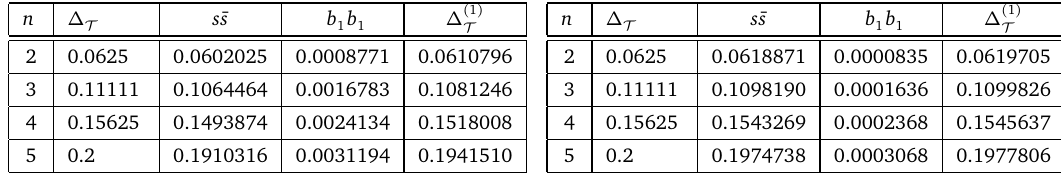
Table 1: The contributions to the sum (73) from the soliton-antisoliton term ( s ¯ s ) and b the breather-breather term ( b ) for ξ “ 0.62734 (left) and ξ “ 0.82734 (right). 1 1 The first column shows the exact values of ∆ and the last column the sum of s ¯ s T b and b contributions. As expected, the main contribution comes from the s ¯ s term. 1 1 This contribution gets larger as we approach the threshold value ξ “ 1, while the breather contribution is